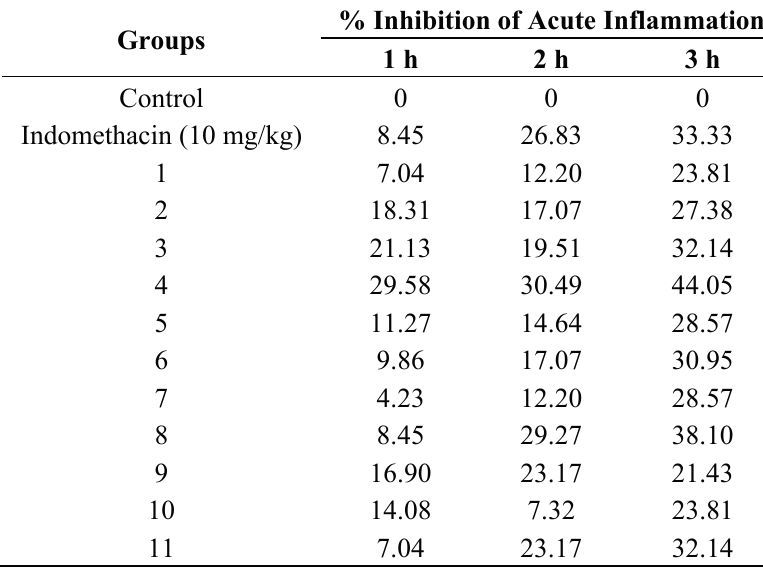
Table 2. % Inhibition of acute inflammation (carrageenan-induced paw edema), ( n = 8).